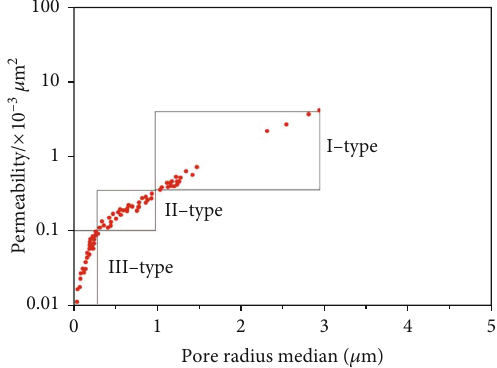
Figure 8: Reservoir classi fi cation of the tight oil reservoir in the study